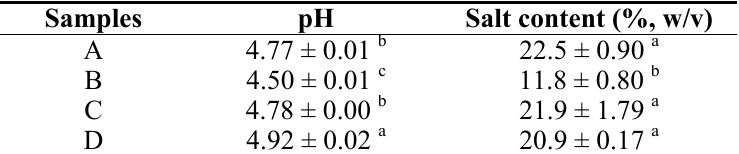
Table 1. pH and NaCl content of four Budu